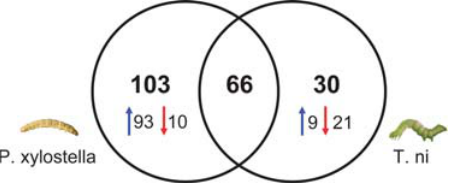
Figure 2. Venn Diagram of the numbers of overlapping and non- overlapping Boecheragenes up-regulated (blue arrows) and down- regulated (red arrows) in response to herbivory by T. ni and P. xylostellacaterpillars .